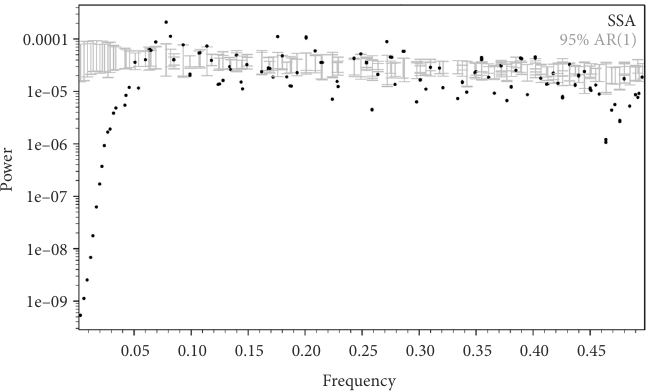
Figure 1. Oscillatory behavior (cycle) of the UK GDP series 1270–2016 (source: Authors’